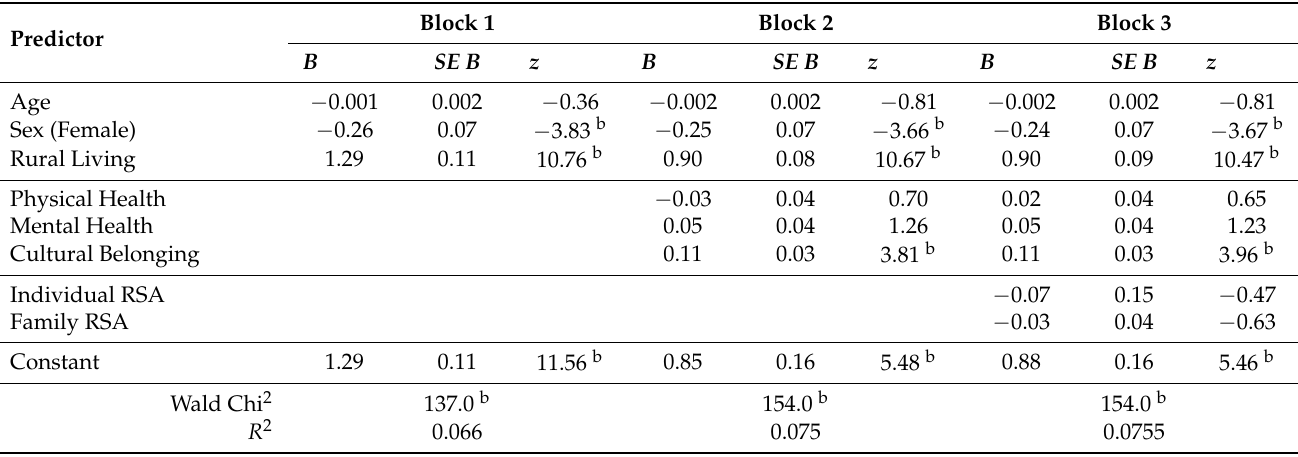
Table 2. Predictors of the frequency of land-based activity engagement for First Nations individuals living